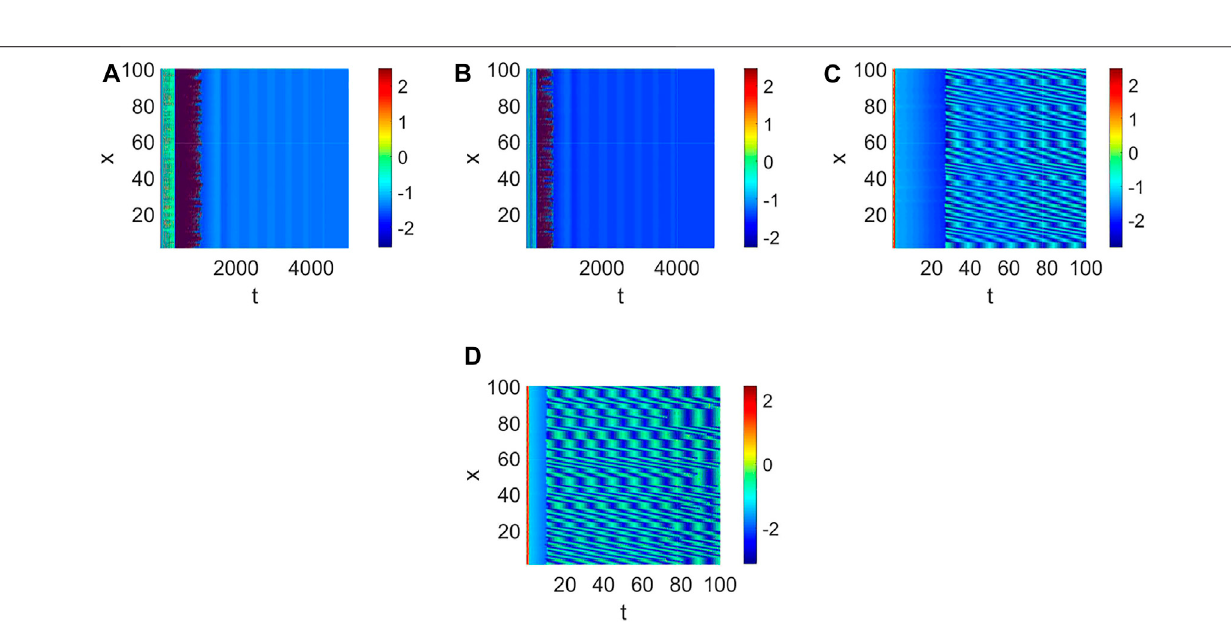
Frontiers in Physiology |